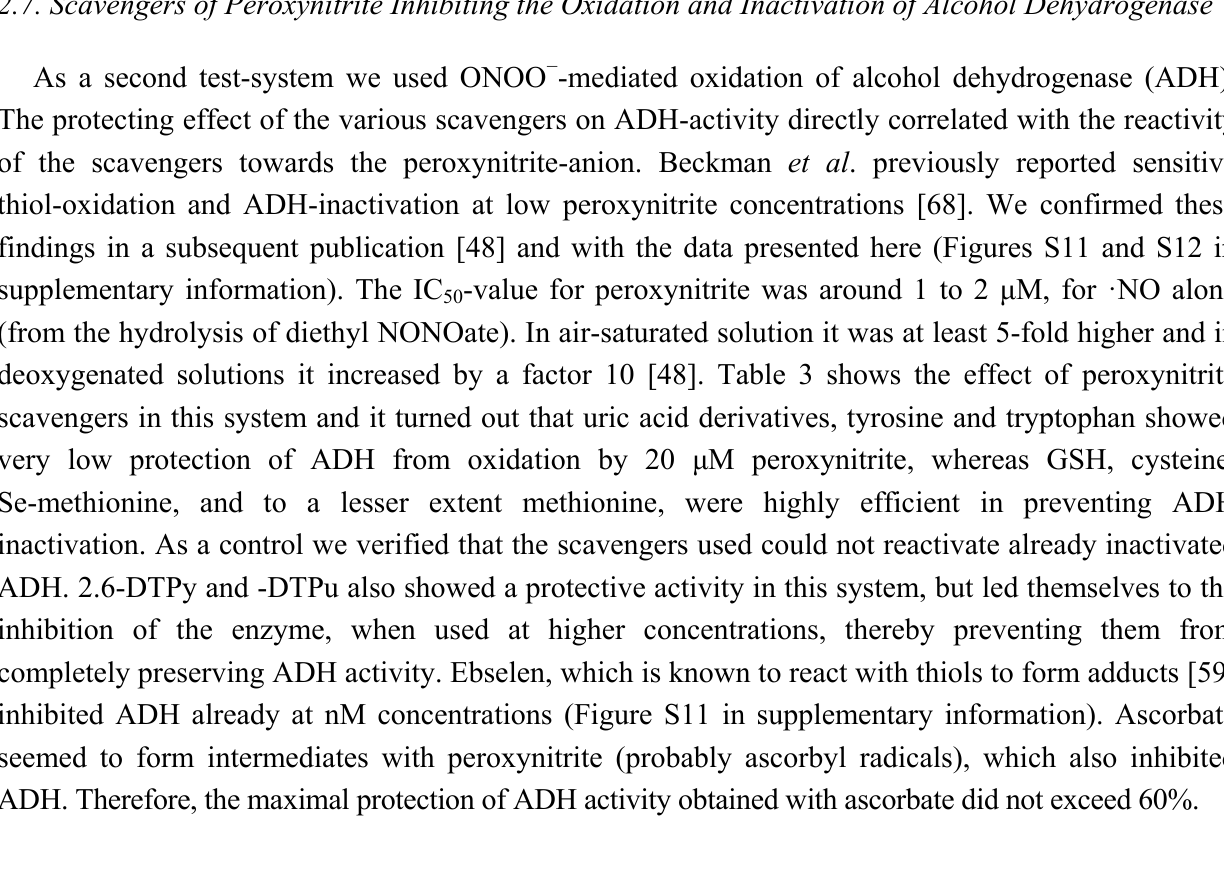
-values) of various compounds for 50